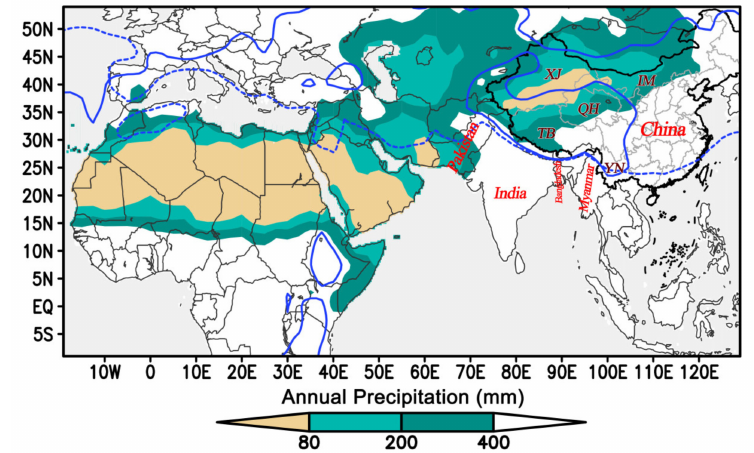
Figure 1. Mean annual precipitation (filled color), 10 ◦ C isotherm in January (blue dotted line, the south side is ≥ 10 ◦ C) and 20 ◦ C isotherm in July (blue solid line, the south side is ≥ 20 ◦ C) averaged for 20 years (2000–2019). Potentially suitable habitat for the desert locust should, at least, satisfy conditions with an annual precipitation ≤ 400 mm and air temperature in July ≥ 20 ◦ C. As eggs cannot survive when the temperature is below 10 ◦ C, for year-round breeding, the temperatures in winter should be above 10 ◦ C. Taking all these things together, only small areas in Xinjiang and Inner Mongolia provinces could provide an ephemeral (summer) habitat for the desert locust in China. TB-Tibet, YN-Yunnan, QH-Qinghai, IM-Inner